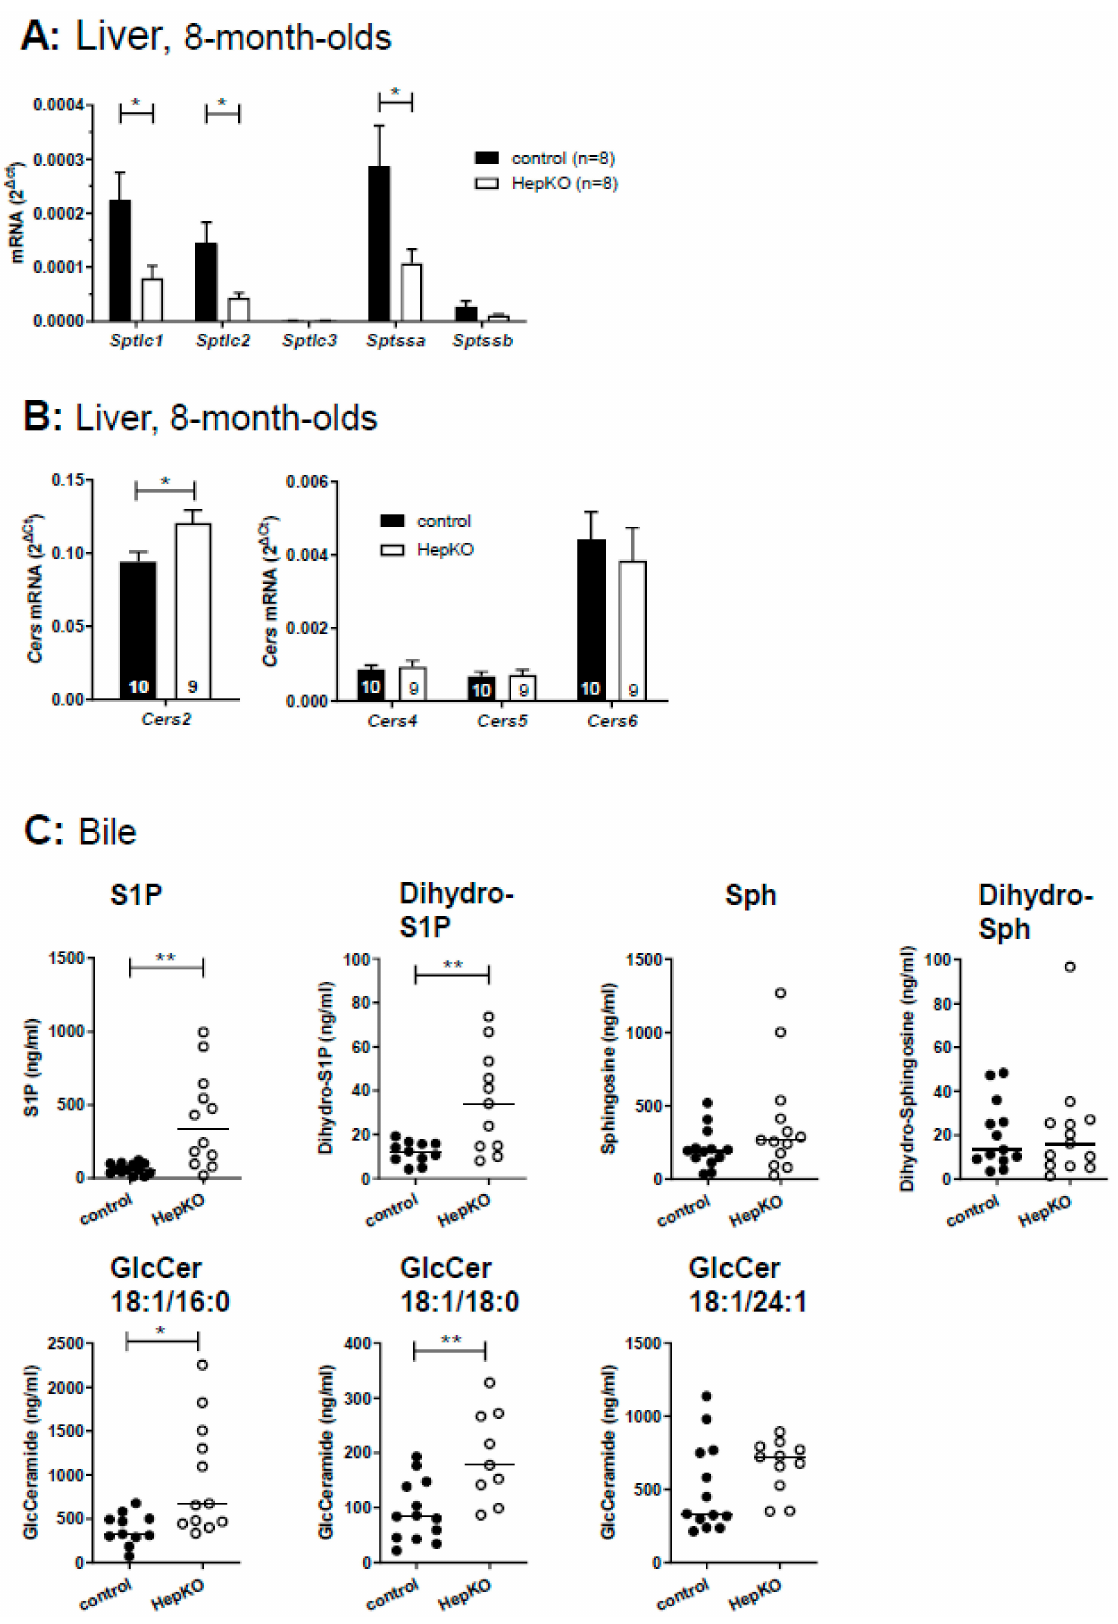
Figure 4. Expression of serine palmitoyltransferase subunits and ceramide synthases in liver of Sgpl1 HepKO mice, and secretion of sphingolipids into bile. ( A , B ) mRNA levels of different subunits of serine palmitoyltransferase ( A ) and